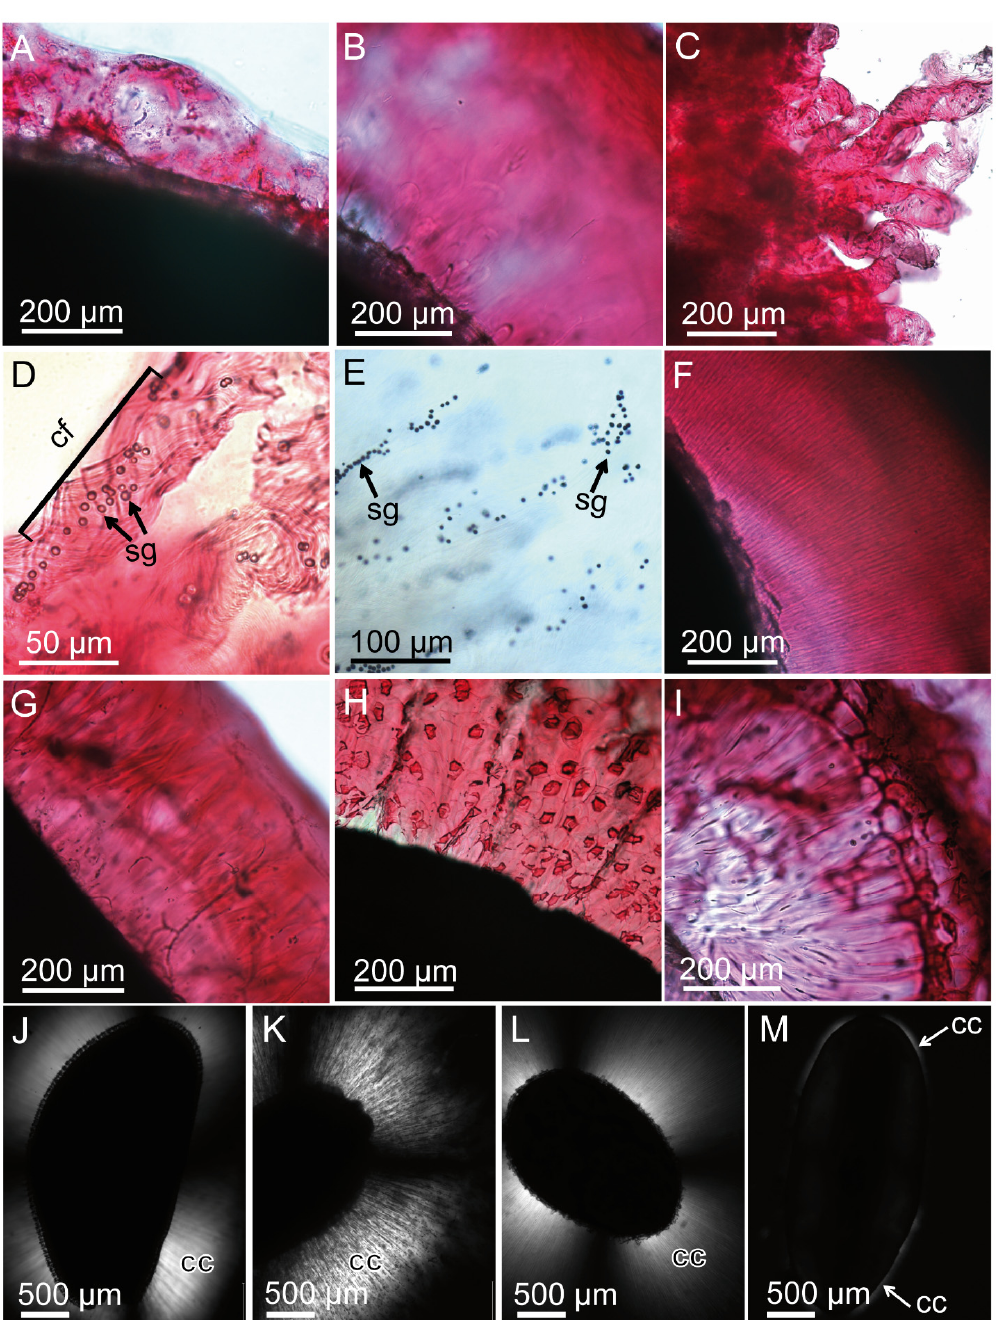
Figure 2. Mucilage morphology presented using optical microscopy. ( A – I ) Staining with ruthenium red. Characteristic purple color indicates the presence of pectins in the mucilage; ( A ) L. usitatissimum ; ( B ) L. sativum ; ( C – E ) O. basilicum ; ( D ) Characteristic “mucilaginous tubules” with spirally coiled cellulose fibrils (cf) with enclosed inside starch grains (sg) in the mucilage of O. basilicum ; ( E ) staining of starch grains with IKI. The grains have dark coloration; ( F ) S. sclarea mucilage with delicate, radially spread cellulose fibrils; ( G ) P. lanceolata ; ( H , I ) P. ovata seed mucilage ( H ) and husk mucilage ( I ); ( J – M ) detection of crystalline cellulose (cc) (polarized light microscope) in the mucilage envelope; ( J ) L. sativum ; ( K ) O. basilicum ; ( L ) S. sclarea ; ( M ) P. lanceolata